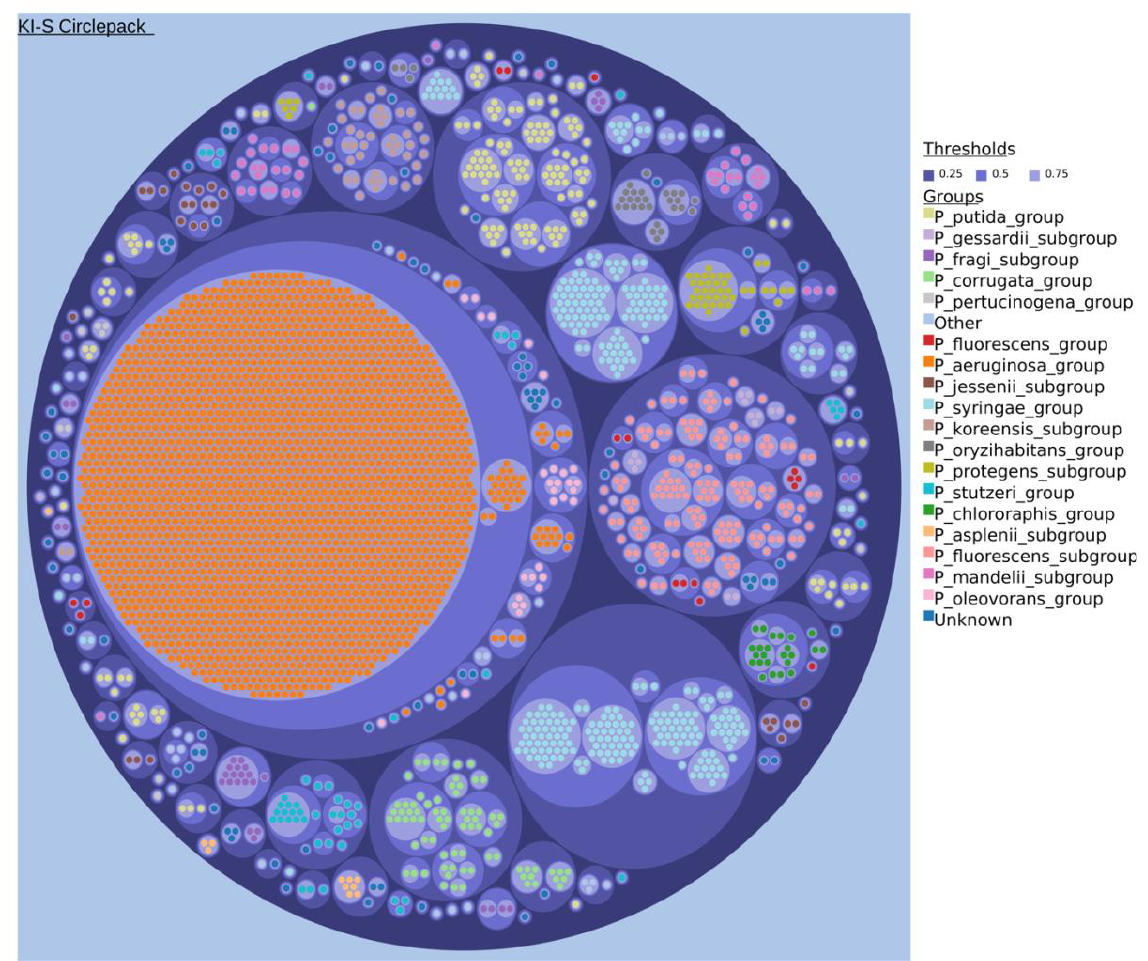
Figure 3. Clustering of Pseudomonas genome sequences. Zoomable circle packing representation of Pseudomonas genome sequences (n = 3,623). Similarities between genome sequences were assessed